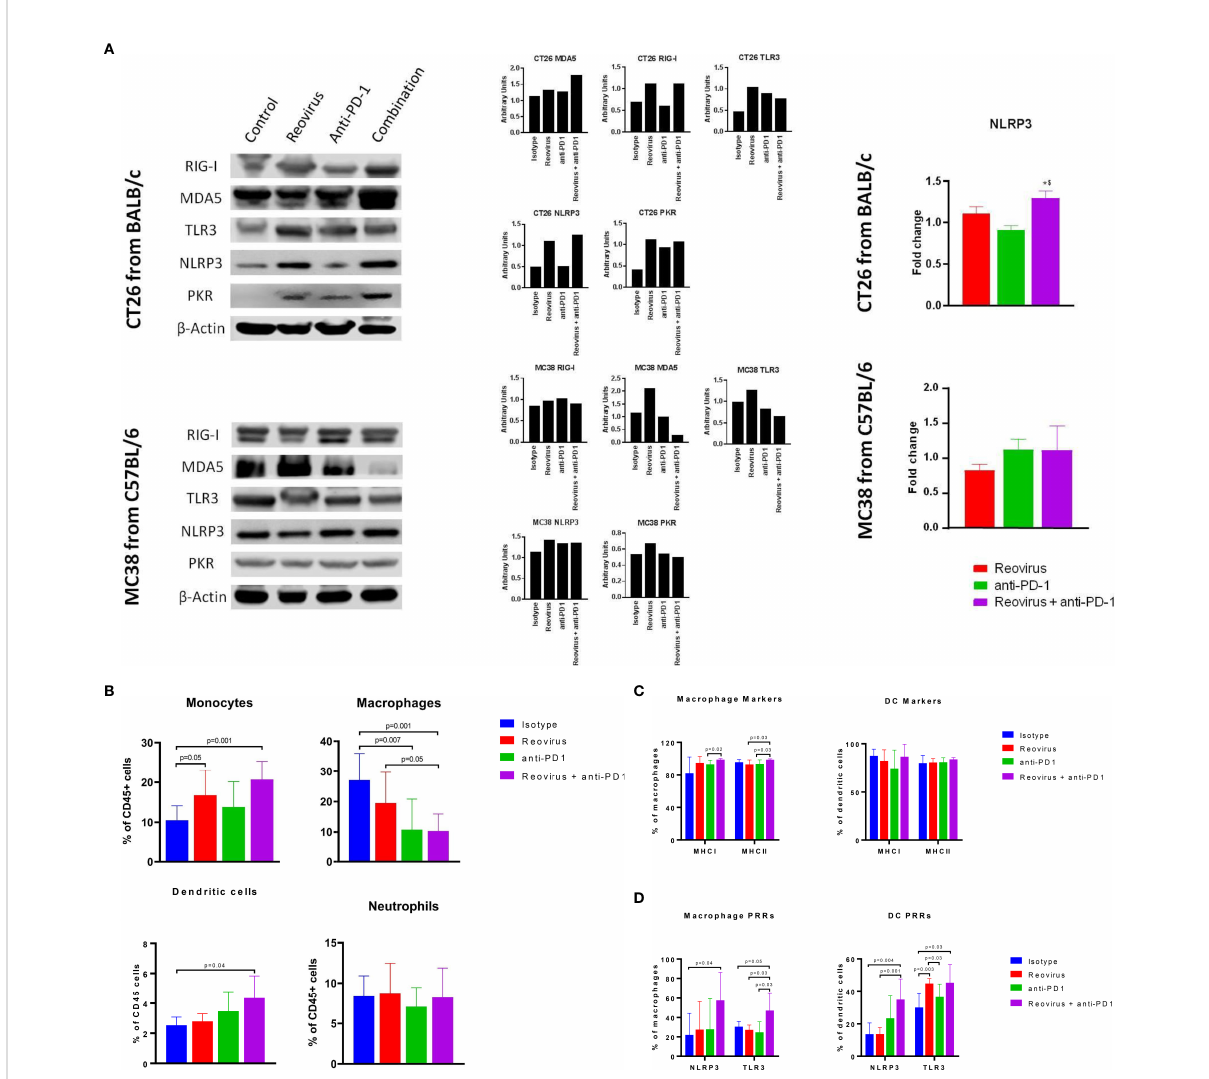
FIGURE 7 Activation of pattern recognition receptors (PRRs) and innate immune system in CT26 and MC38 tumors treated with reovirus, anti-PD-1 and their combination. (A) Protein-level changes among pooled samples - reovirus infection upregulated most of the PRRs, except for cytoplasmic RIG-I, in MC38. Combination treatment increased all PRRs investigated, except TLR3 and PKR, in CT26, and either unaltered or decreased in MC38. Combo drastically reduced membrane bound TLR3 and cytoplasmic PKR in MC38. NLRP3, which is an in fl ammasome activation mediator, signi fi cantly increased by the effect of reovirus in the TME of CT26. Expression of dsRNA sensing PKR was increased by reovirus treatment in CT26 in combination group, however, there was no alteration in expression amongst the different groups in MC38. (B) Effect of reovirus and anti-PD1 treatment on innate immune cell populations. Reovirus single agent and combo treatment increased monocytes and DCs (p=NS for DCs with reovirus), and decreased macrophages. Anti-mouse PD-1 treatment alone increased percentages of monocytes and DCs in the TME. (C) Differential expression of antigen presentation markers on the surface of macrophages and dendritic cells. Reovirus or combo treatment didn ’ t alter MHC Class I and II expressions signi fi cantly among these cell populations. Only macrophage MHC I and II expression signi fi cantly increased in combo compared to anti-mouse PD-1 single agent. (D) Selective activation of PRRs in tumor-derived myeloid cells. While combination treatment did in all groups, neither of the single agents signi fi cantly altered PRRs expression, except anti-PD-1 and reovirus on TLR3 among DCs. NLRP3 and TLR3 expression almost tripled among cell types by the combination